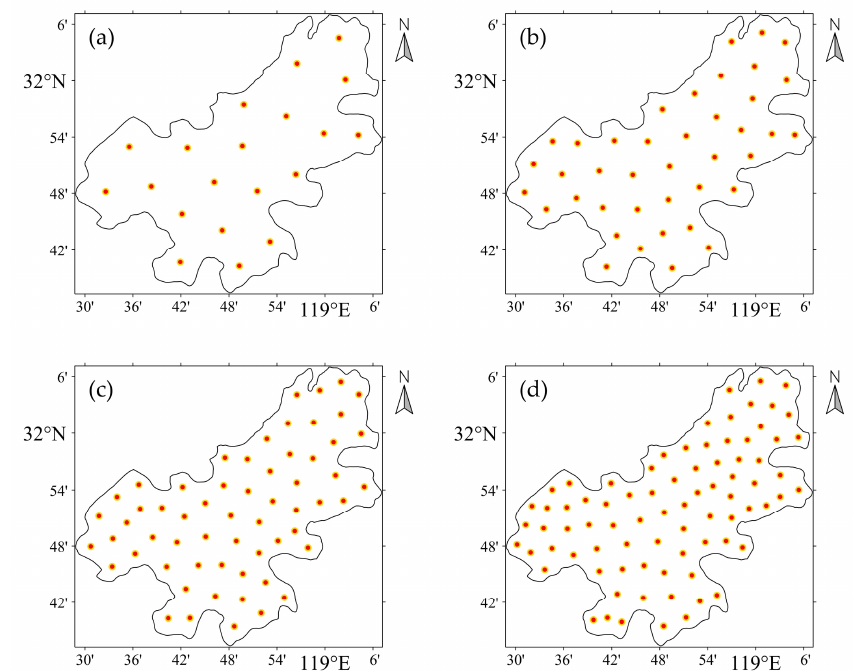
Figure 3. Schemes follow the same formatting. Distribution of the ESL network in Jiangning district, Nanjing: ( a ) ESL network 1; ( b ) ESL network 2; ( c ) ESL network 3; ( d ) ESL network 4. The red points with the yellow outline represent the locations of the ground antennas of the ESLs.